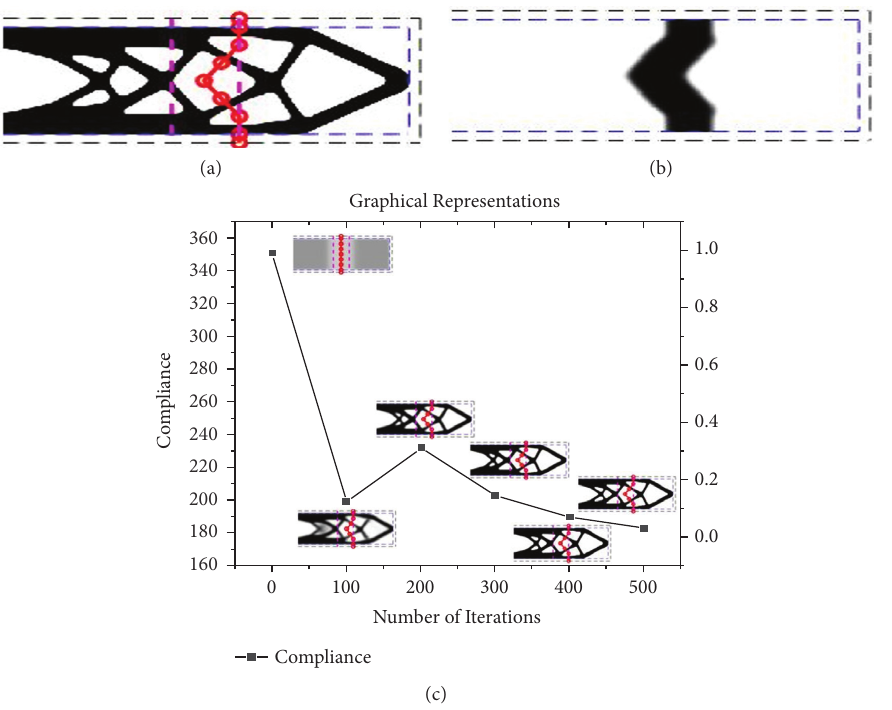
Figure 5: Optimized topologies and compliance for various constraints values. (a) f � 178, r iterations � 50. (b) Shape of optimized projection area. (c) Graphical representation.